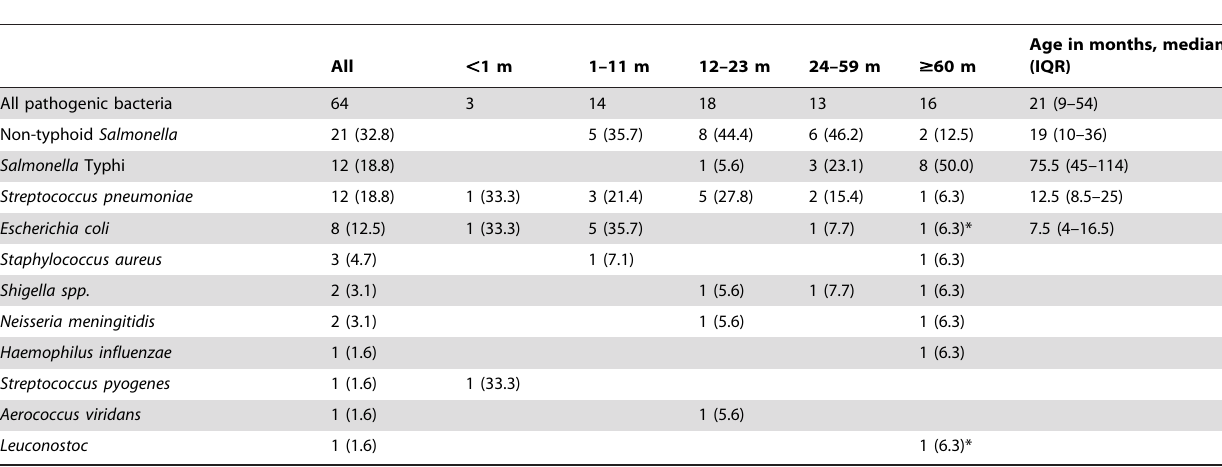
Table 3. Clinically significant organisms isolated from blood culture and age-specific frequencies.